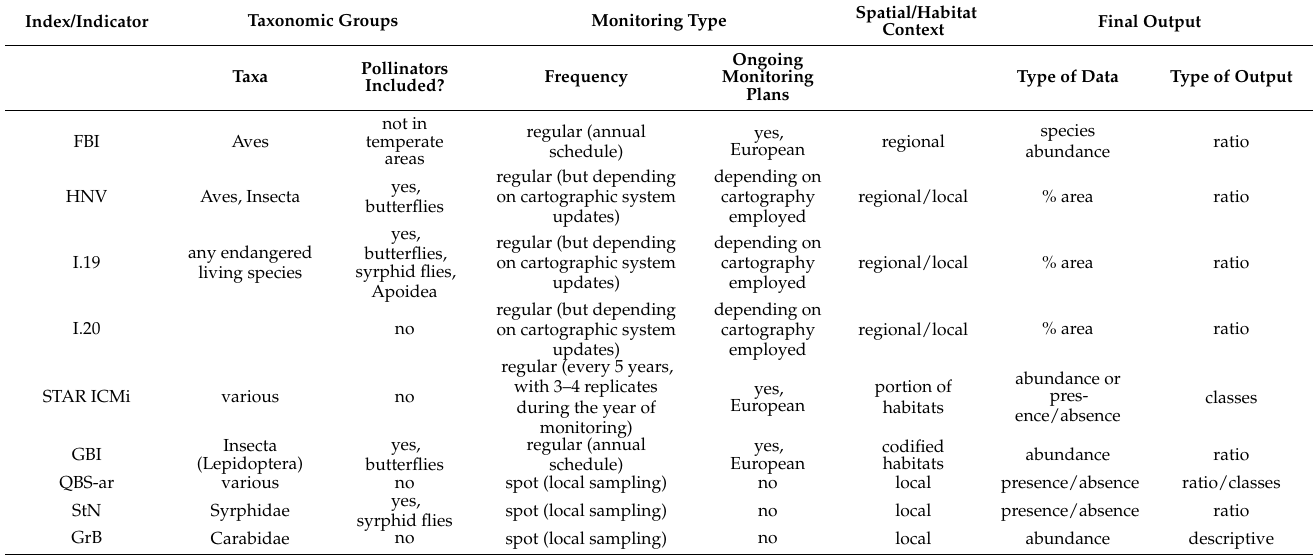
Table 1. Main characteristics of the nine indicators. For STAR ICMi, various indicates Anellida, Arthropoda, Bryozoa, Cnidaria, Mollusca, Nematoda, Nemertea, Porifera, Rotatoria, Platyhelminthes; for QBS-ar, various indicates Arachnida, Chilopoda, Diplopoda, Insecta, Malacostraca, Pauropoda,